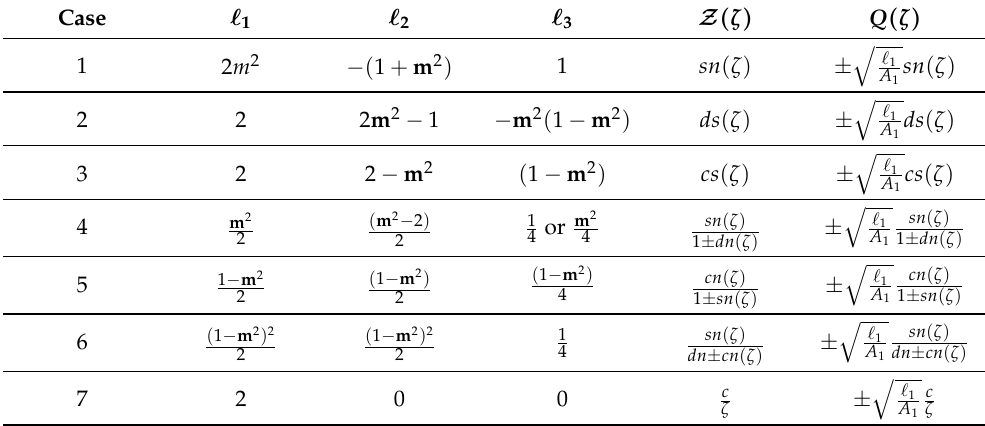
Table 2. All possible solutions for wave Equation (12) when (cid:96) 1 > 0.